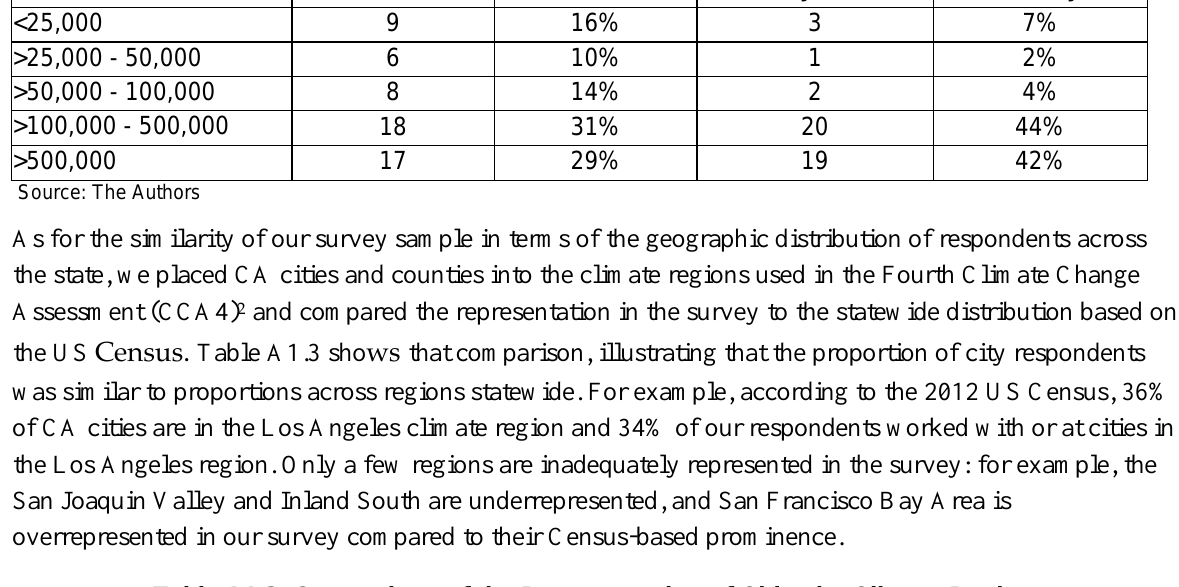
Table A1.3: Comparison of the Representation of Cities by Climate Region, Statewide and in the